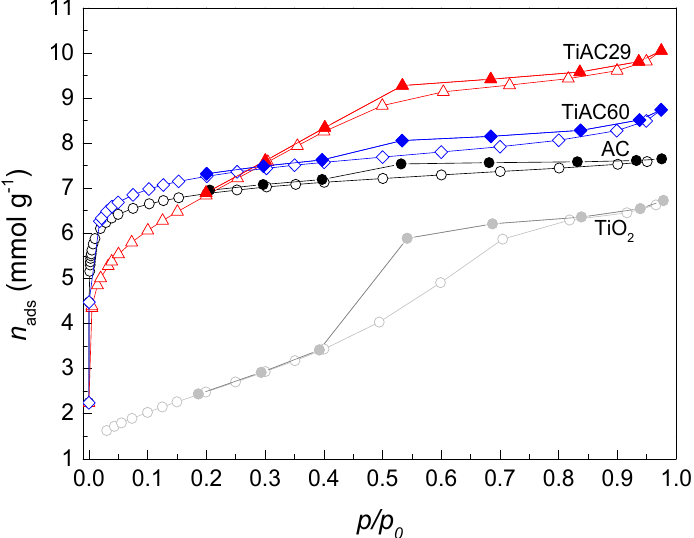
Figure 4. N 2 adsorption–desorption isotherms at − 196 ◦ C of the AC, TiO 2 and TiACX composites. The empty and filled symbols represent adsorption and desorption data, respectively. Table 2. Textural characteristics of the materials.